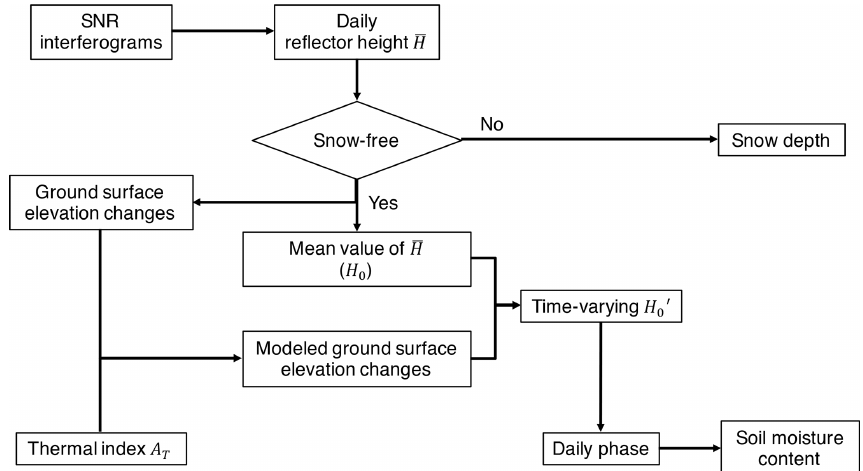
Figure 4. Diagram of the three-in-one framework for integrating the GPS-IR measurements of ground surface elevation changes, soil mois- ture, and snow depth at one site.